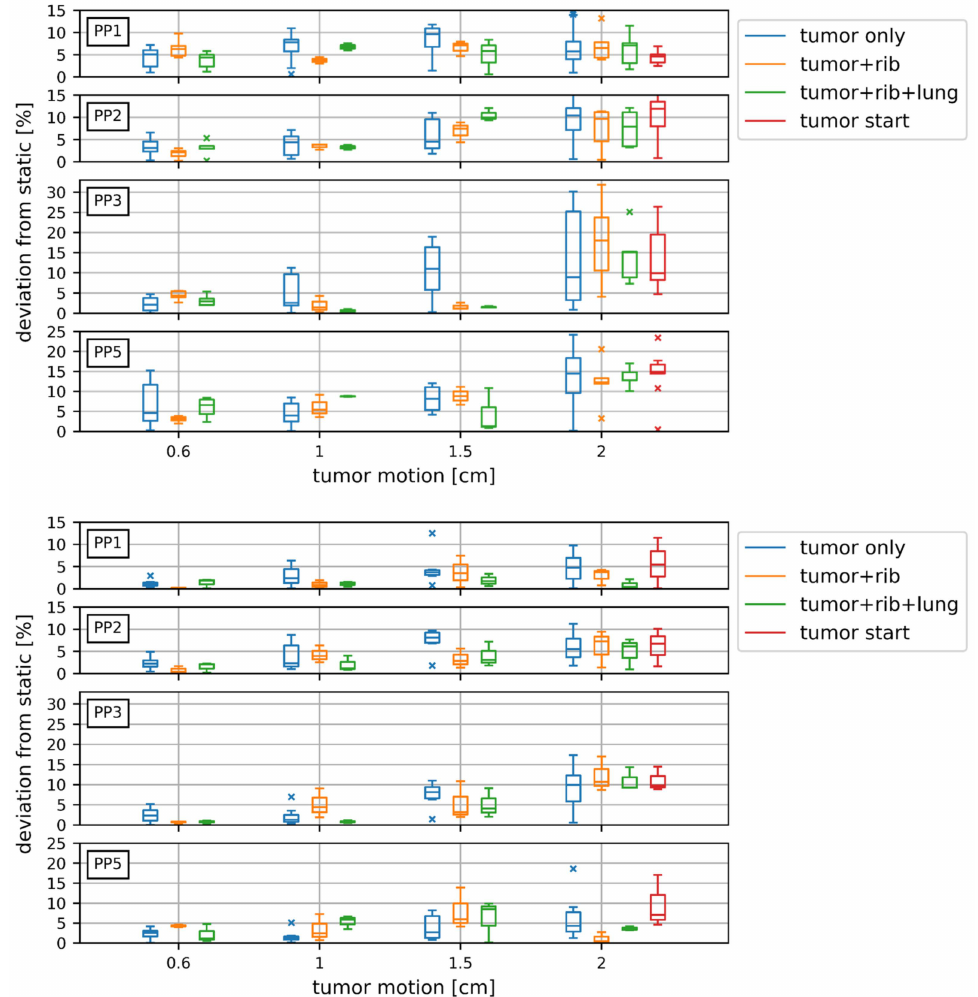
Figure 2. Boxplots containing the deviation from the static dose for different motion scenarios (tumour motion of 0.6, 1, 1.5, and 2 cm with or without a combination of rib and lung motion) for carbon ion ( upper ) and proton ( lower ) irradiations. The red boxplot represents different breathing starting